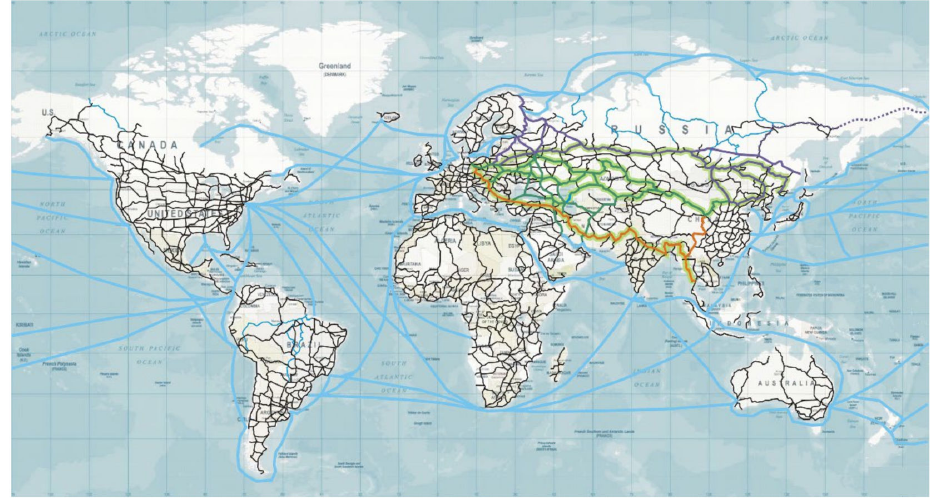
Figure 9. The model of Eurasian transcontinental links in the world transport system (black—existing transport links, on the territory of Eurasia—not involved in transcontinental relations; blue—the main river transport corridors; light blue—the main sea and transoceanic routes; purple—the main existing Trans-Siberian railways route and formed diagonal links; green—new east–west rail corridor routes via Kazakhstan, as well as formed diagonal and meridional links between the main latitudinal corridors; orange—the southern corridor being formed)